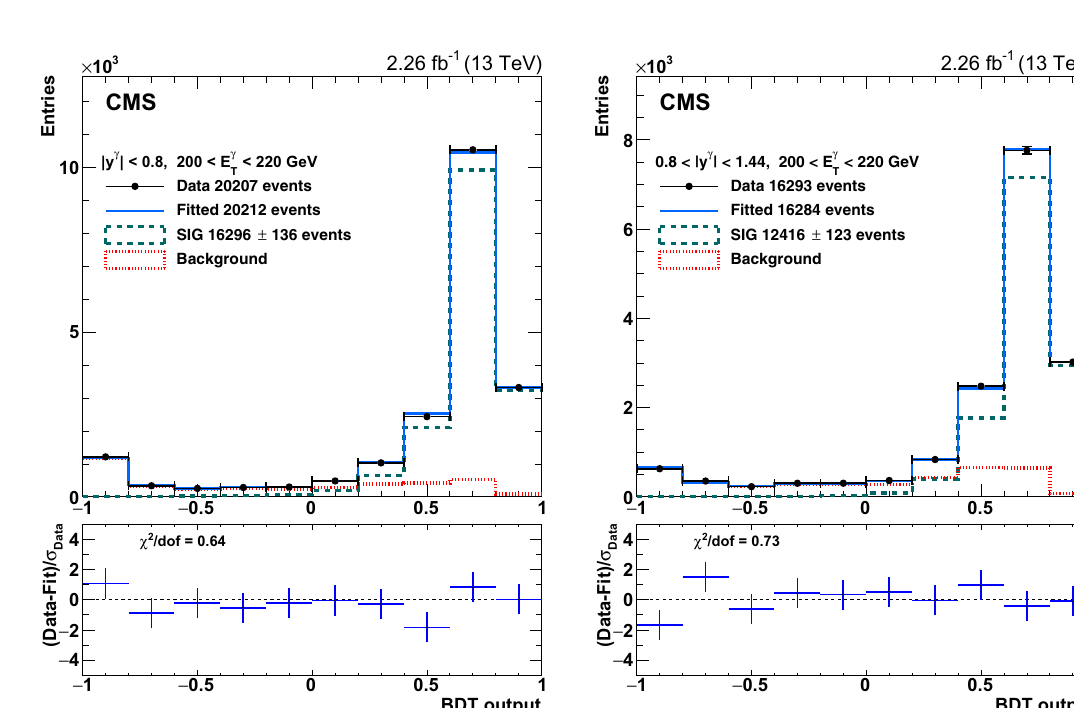
Fig. 1 Distributions of the BDT for background photons in the 200– 220GeV bin for the EB region. The points show events from a sideband region of the photon isolation selection criteria, the solid histogram shows the events in the signal region in simulated QCD multijet events, andthedashedhistogramshowsthesidebandregionforsimulatedQCD multijet events. All three samples have their statistical uncertainties shown as error bars